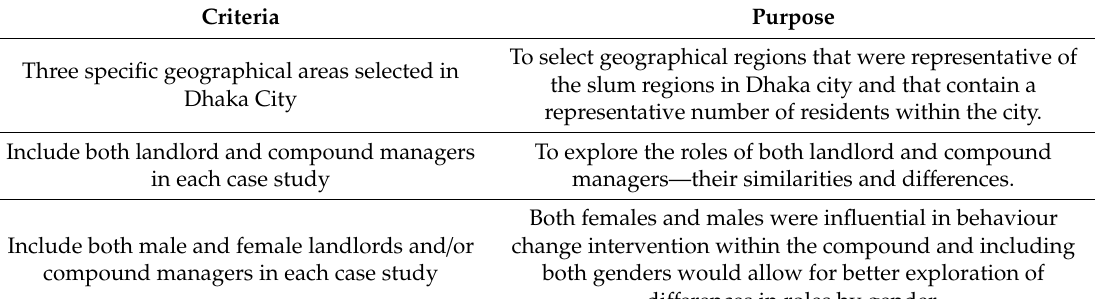
Table 2. Criteria for selecting three compounds as case studies. Criteria Purpose